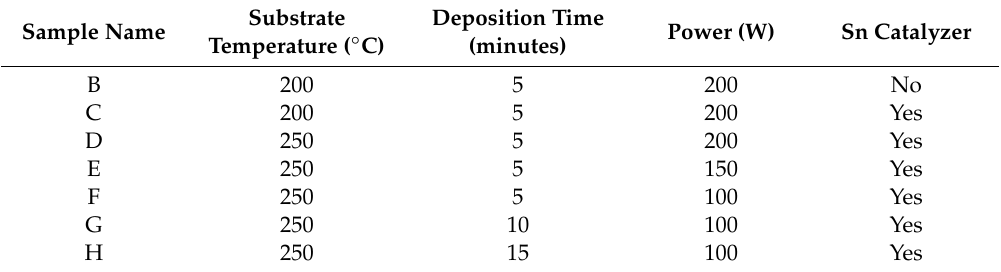
Table 1. Deposition parameters for ZnO samples. Sample name refers to Figure 3b–h